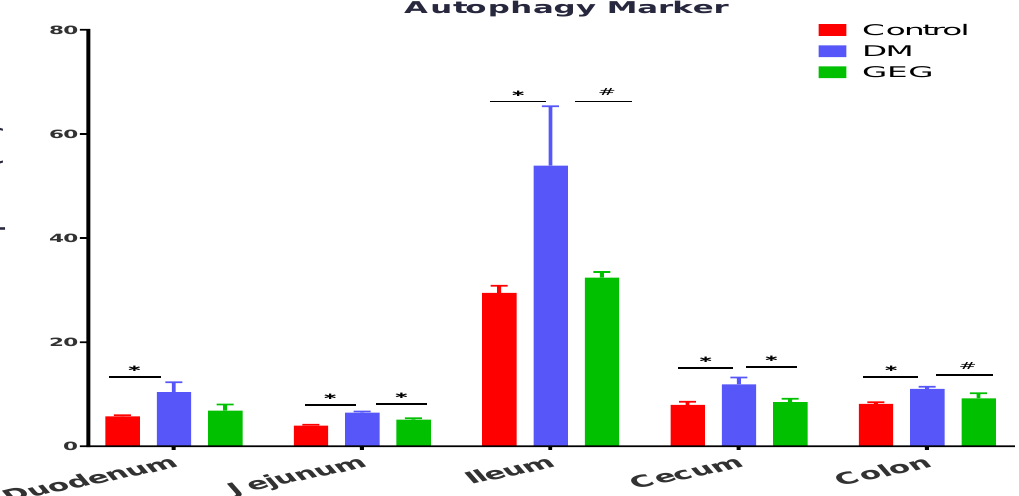
Figure 11. Effect of gingerol-enriched ginger (GEG) on mRNA gene expression of P62 in duodenum, jejunum, ileum, cecum, and colon of rats. Data is expressed as mean ± SEM. n = 6 – 8 per group. Data was analyzed by one-way ANOVA followed by a post hoc Tukey’s test. * p < 0.05. # 0.05 < p < 0.1. Figure 12 shows the effects of GEG supplementation on gene expression of PINK1, a mitochondrial kinase, in the intestinal tissues of DM rats. Compared with non-DM rats (the control group), the DM mice had increased PINK1 gene expressions in the duodenum, ileum, cecum, and colon (Figure 12A). GEG supplementation resulted in decreased